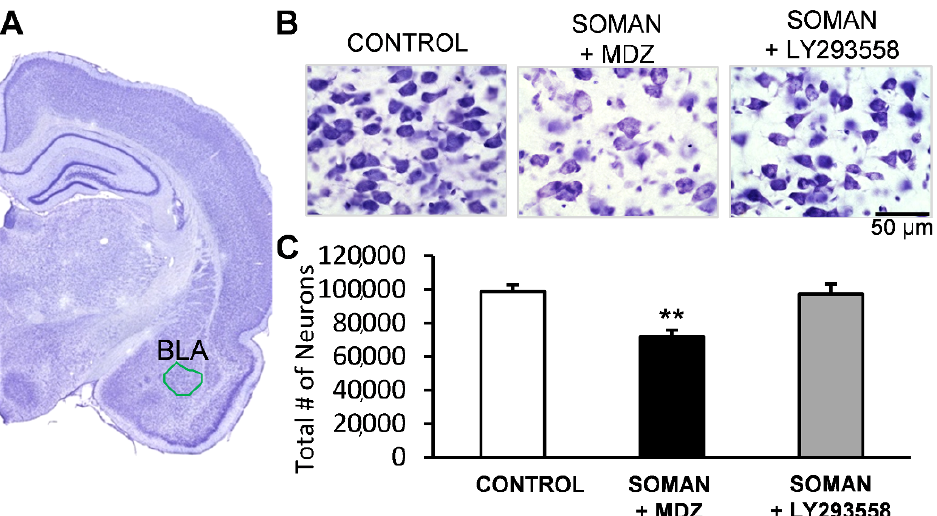
Figure 2. Thirty days after soman exposure, there was significant neuronal loss in the BLA of the MDZ-treated group but not the LY293558-treated group. ( A ) Panoramic view of a Nissl-stained section showing the area where neuronal loss was assessed; ( B ) Representative photomicrographs from a control (not exposed) rat and an MDZ- or LY293558-treated soman-exposed rat (total magnification 630×; scale bar, 50 µm); ( C ) Group data; sample sizes: n = 8 for each group; ** p < 0.01 compared with either the control or the SOMAN + LY293558 group (ANOVA, Bonferroni post hoc test).